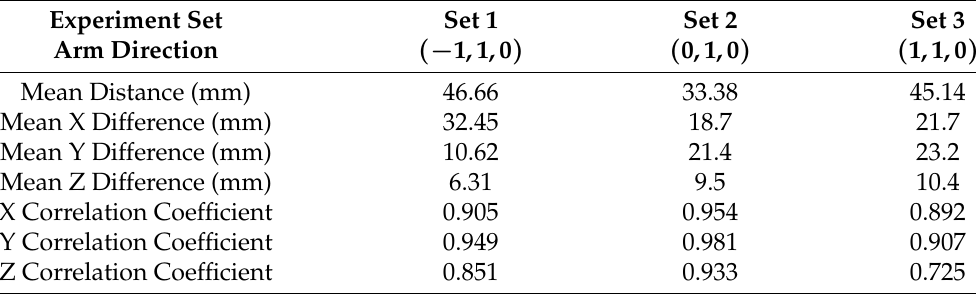
Table 4. Position difference between camera estimation and sensor